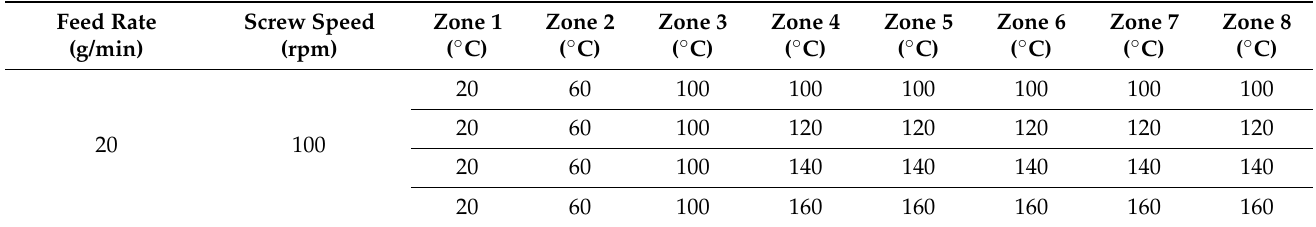
Table 2. Process parameters used for melt granulation of metformin HCl (75% w/w ) and polymer (25% w/w